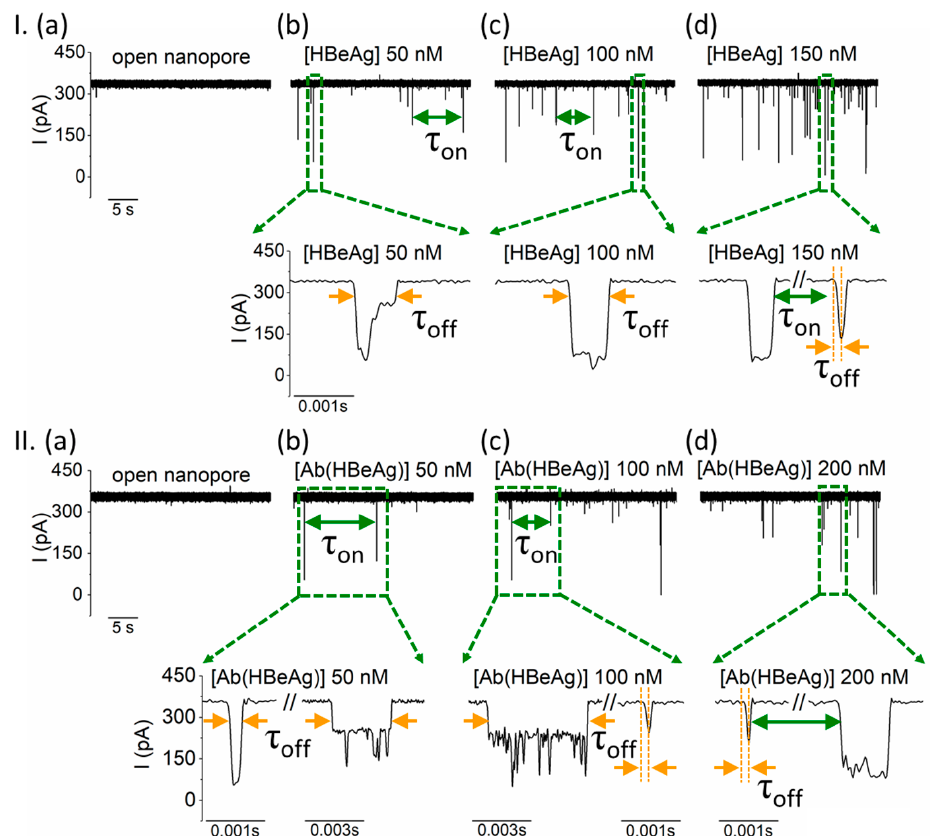
Figure 2 . Despite their relative large size, the interactions between the cis -side-added HBeAg and Ab(HBeAg) with the α -HL nanopore are visible in electrophysiology experiments. ( I ) Reversible collisional interactions between the positively biased α -HL ( a ) and the cis -side-added HBeAg, present at 50 nM ( b ), 100 nM ( c ), and 150 nM ( d ) are seen as downwardly oriented spikes. The expanded traces illustrate the degree of heterogeneity of the blockade events, suggestive of geometrical re-orientations or/and structural changes of the captured analyte during individual bumping events. ( II ) The ionic current through a positively biased nanopore ( a ) is transiently blocked when the monoclonal antibody Ab(HBeAg) is added on the cis side of the chamber at incremental concentrations of 50 nM ( b ), 100 nM ( c ), and 200 nM ( d ), as a result of transient occlusions of the vestibule entrance of the nanopore during collisions. As presented in the expanded traces, the rich diversity of blockade substates manifested during individual collisional events, all characterized by various τ off values, supports the hypothesis of a highly dynamic state of the transiently captured antibody in terms of orientation and/or tertiary structure, all leading to various degrees of nanopore occlusion. The traces were recorded at an applied potential ∆ V = +180mV in a 2 M KCl electrolyte solution, buffered at pH = 8 with a 10 mM HEPES